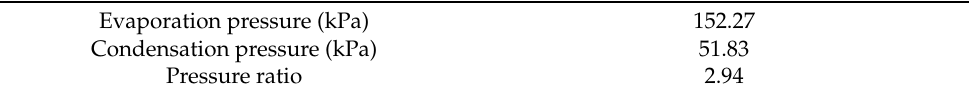
Table 1. ORC operating conditions for cyclopentane from initial analysis, operating between 25 ◦ C and 70 ◦